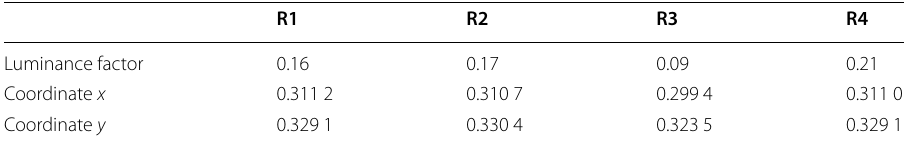
Table 4 Chromaticity measurement values of the 4